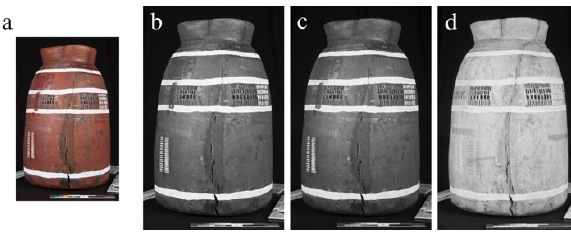
Figure 5. Mango wood vase test object: (a) visible light image from unmodified camera, (b) greyscale visible light image from unmodified camera (‘VIS’), (c) visible light image from modified camera and visible pass filter (‘mVis’); and (d) NIR image from modified camera and NIR pass filter (‘mIR’).